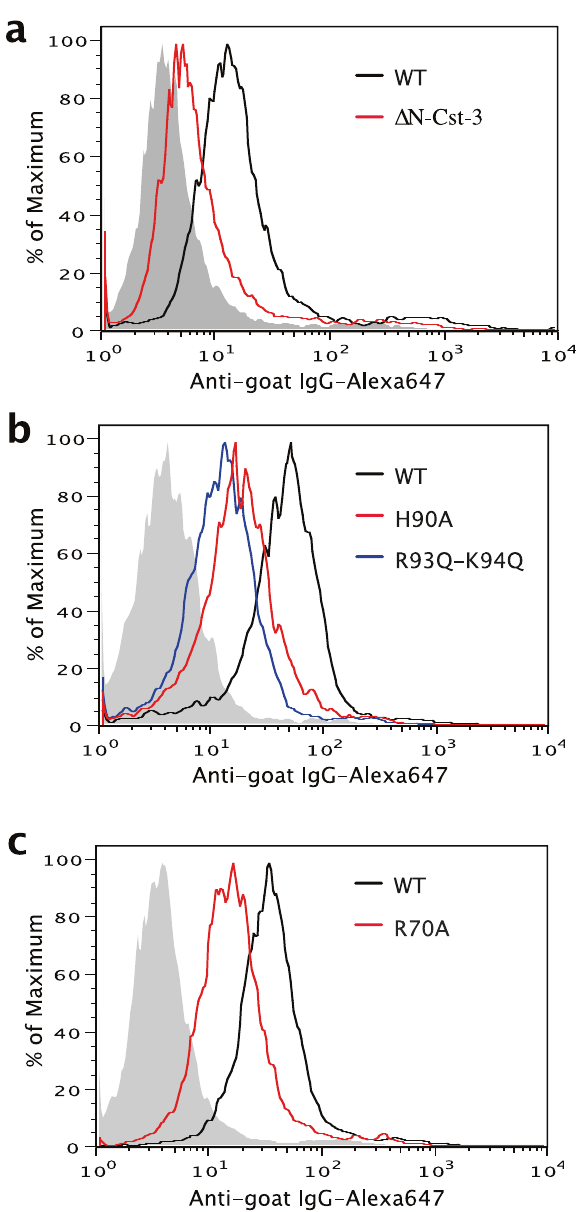
Fig. 5 Binding of Cst-3 mutants to cell-surface HS. Binding of Δ N-Cst-3 ( a ), H90A and R93Q-K94Q ( b ), and R70A ( c ) mutants to CHO-K1 cells were determined by FACS. All proteins were used at 30 µ g/ml and bound Cst-3 were detected by a goat anti murine Cst-3 antibody followed by anti- goat-IgG –